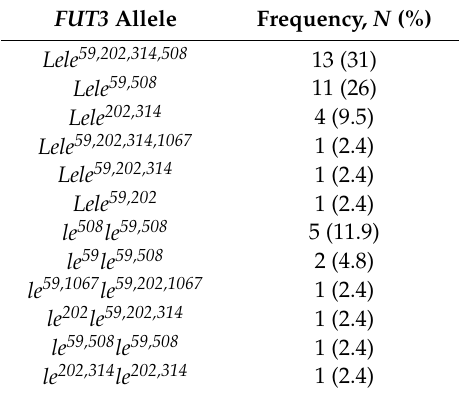
Table 7. FUT3 alleles frequencies observed in South-eastern Brazilian